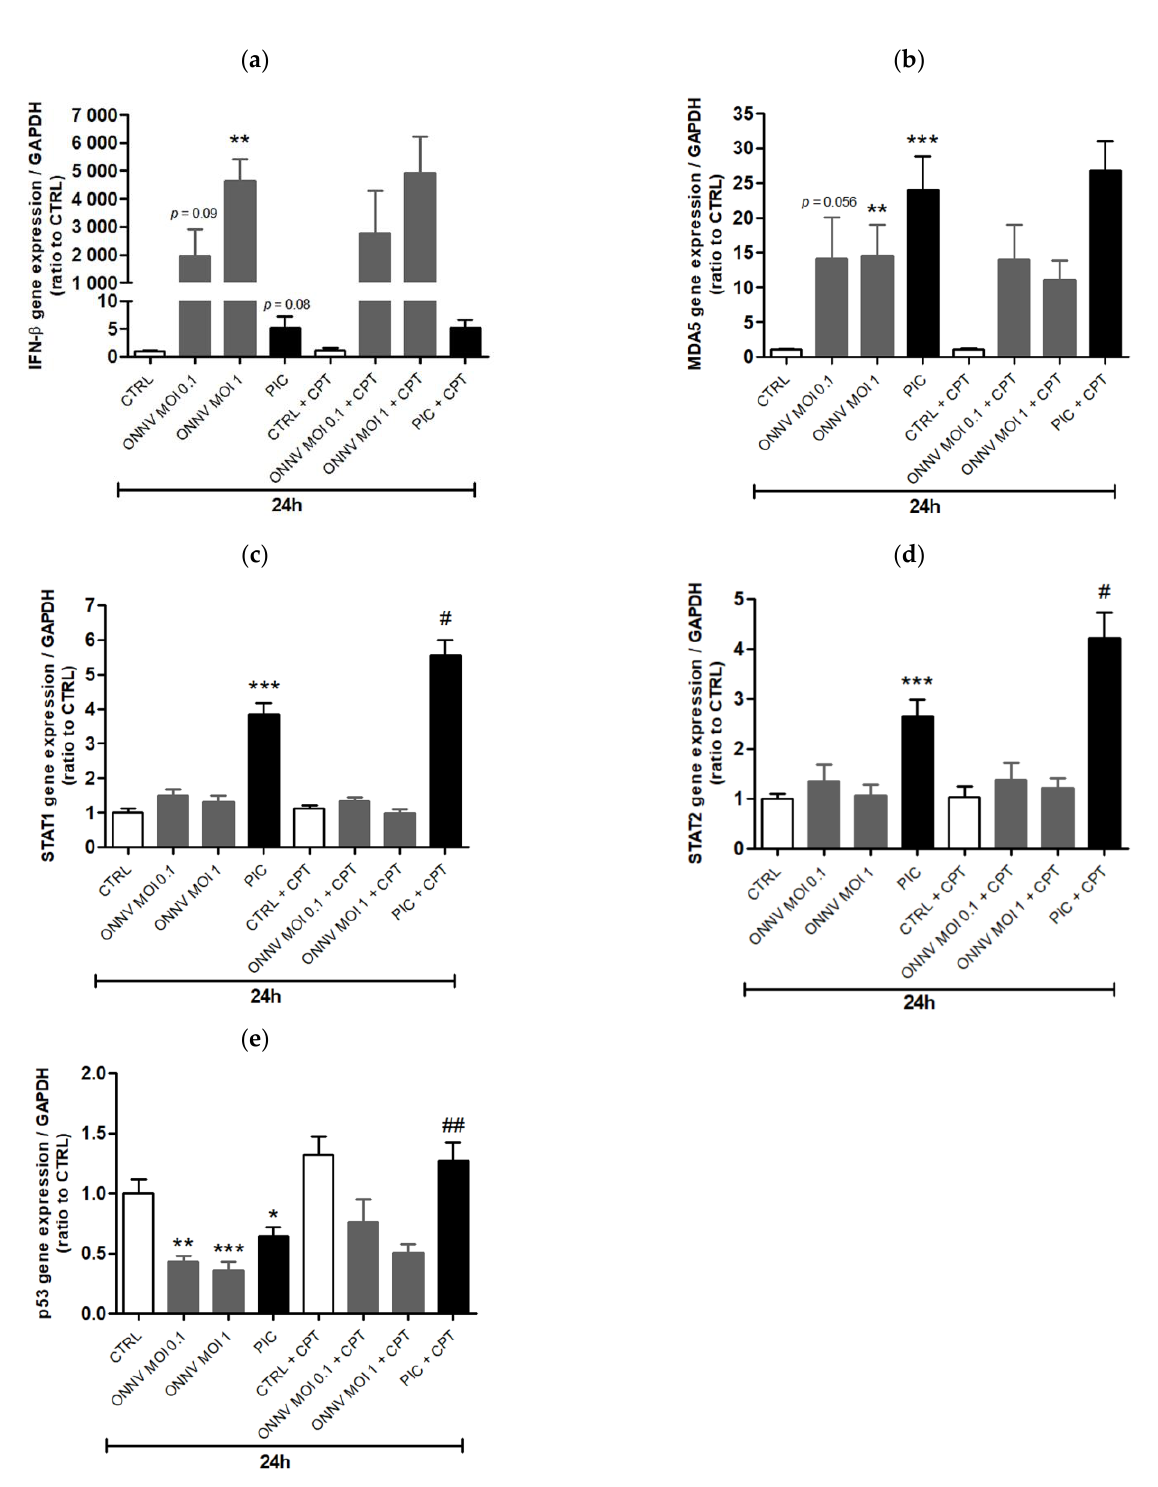
Figure 3. CPT-11 enhances STAT1, STAT2 and p53 (but not type I interferon and MDA5) gene expression in PIC-stimulated HSF. ( a ) IFN- β, ( b ) MDA5, ( c ) STAT1, ( d ) STAT2 and ( e ) p53 mRNA levels from HSF treated with ONNV and PIC and co-treated with CPT-11, for 24 h, were evaluated by RT-qPCR. Results are expressed as mean ± SEM of four independent experiments. Statistical significance is indicated as follows: p -value < 0.05 (*), p -value < 0.01 (**), p -value < 0.001 (***) compared to control at the corresponding time of treatment; p -value < 0.05 (#), p -value < 0.01 (##) compared to the corresponding treatment without